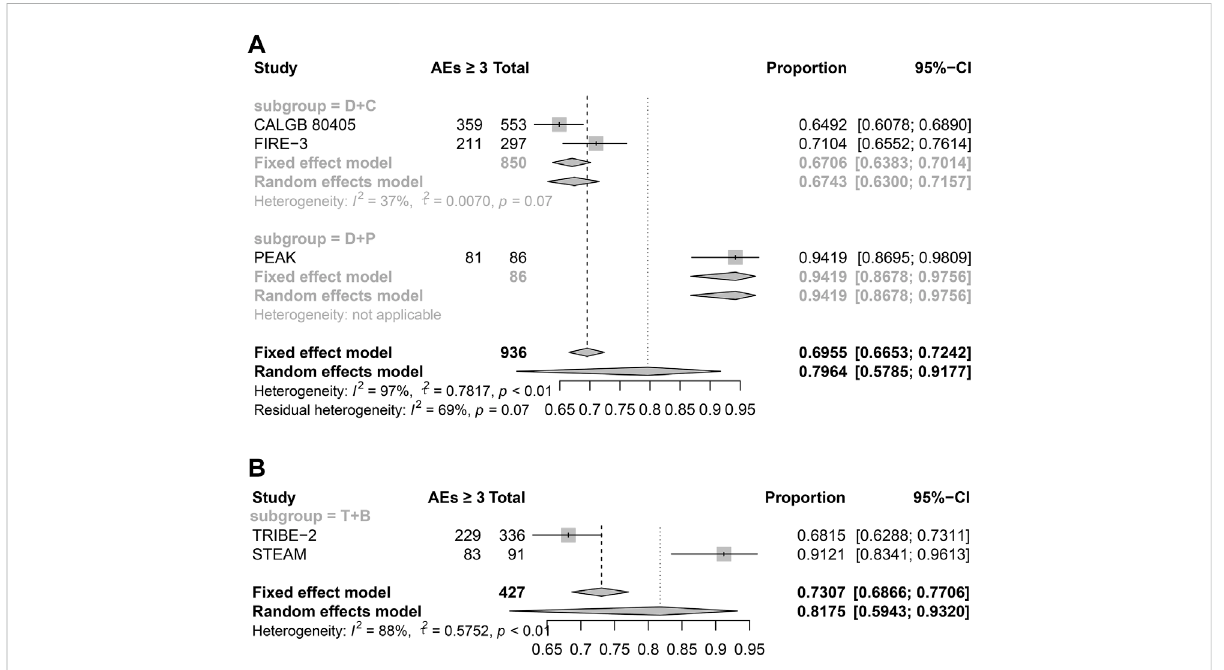
FIGURE 4 TheAEsofdifferenttreatments(Grade ≥ 3). (A) Double-drugregimenpluscetuximab/panitumumab. (B) Triple-drugregimenplusbevacizumab. (N = 1,363, B: bevacizumab; C: cetuximab; D: double-drug; P: panitumumab; T: triple-drug).